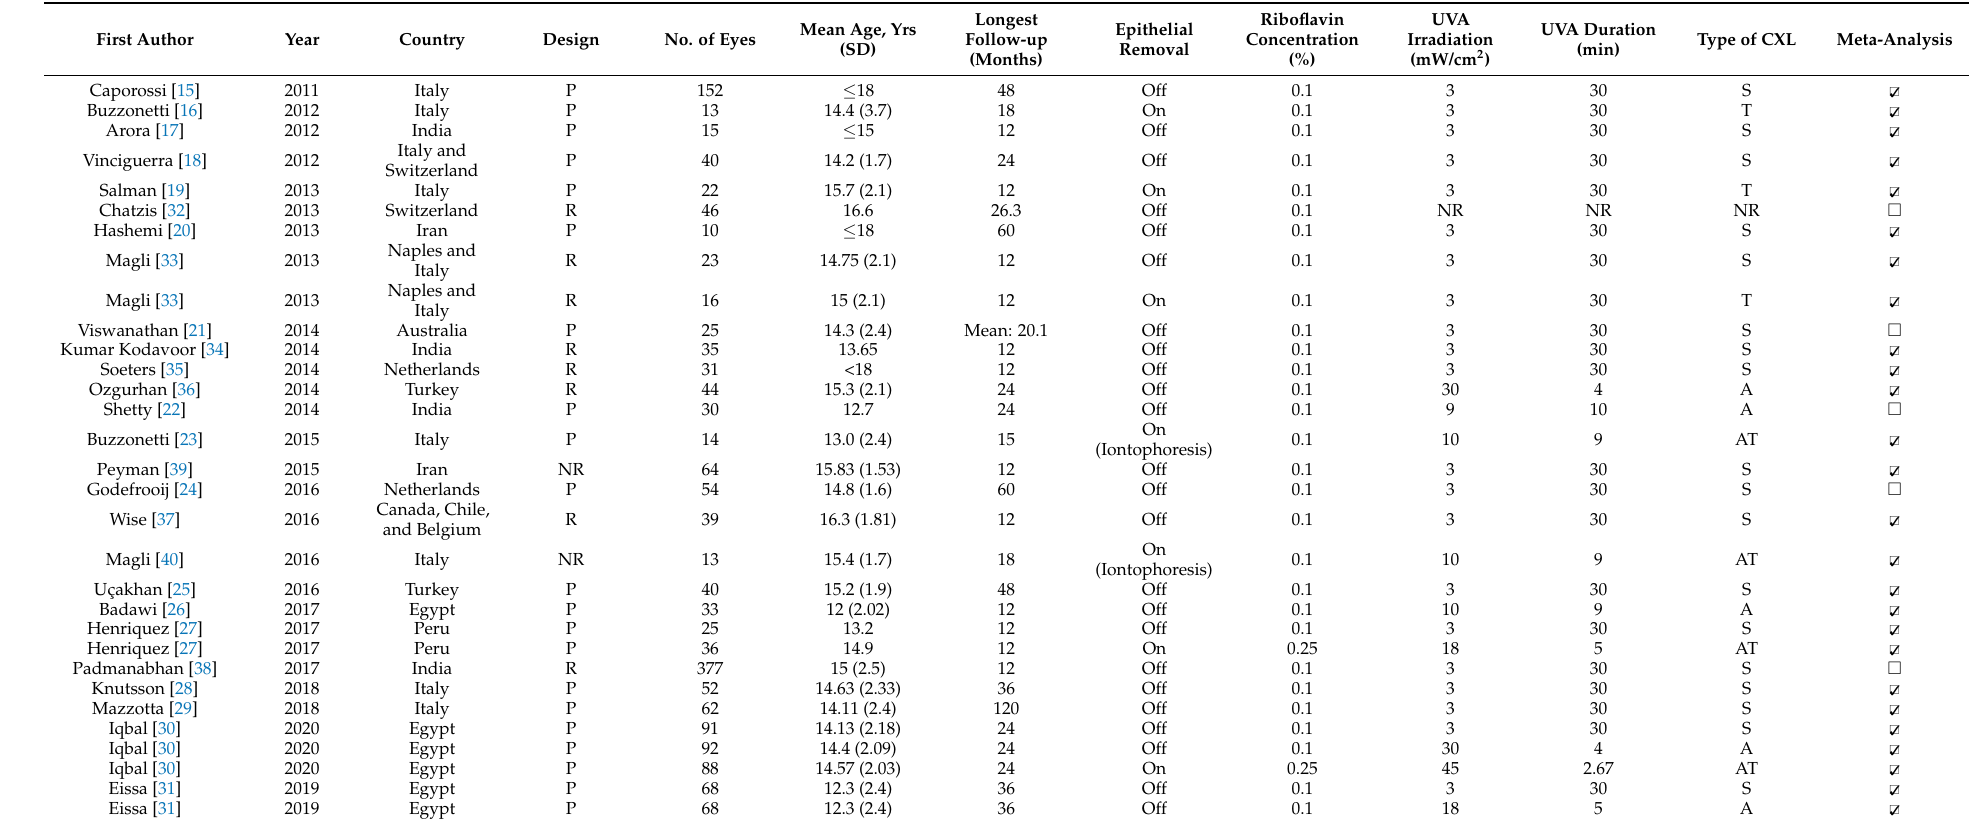
Table 1. Study characteristics of all articles included in the systematic